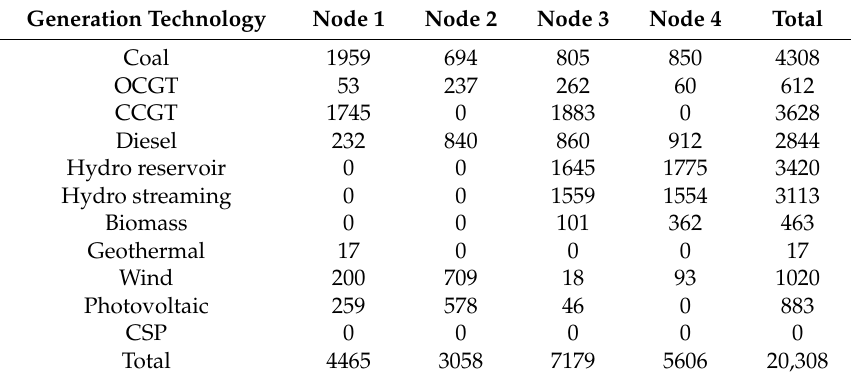
Table 1. Installed capacity per node for 2016 in MW.